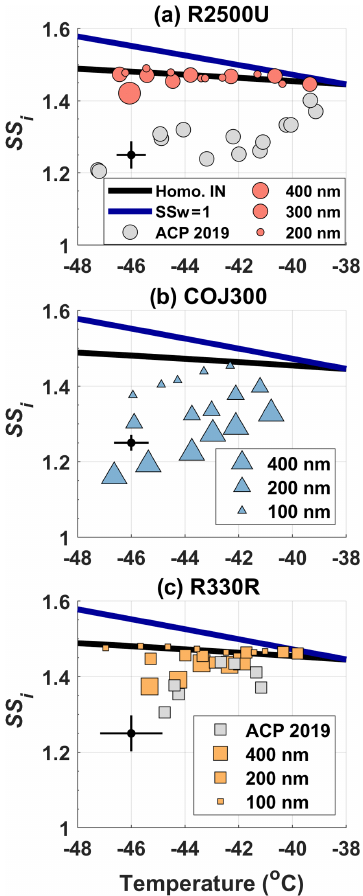
Figure 3. IN-onset SS i (AF = 1%) phase diagram of bare (a) R2500U (circles), (b) COJ300 (triangles), and (c) R330R (squares), respectively. IN-onset data for 800nm R2500U and R330R from a previous study are included and denoted in gray markers (Nichman et al., 2019). Different marker sizes in this study correspond to different d m . Solid blue lines are the water saturation lines, and black lines are homogeneous freezing lines of 200nm aqueous droplets (Koop et al., 2000). A representative error bar of SPIN lamina temperature and SS i is given on the left of each panel.